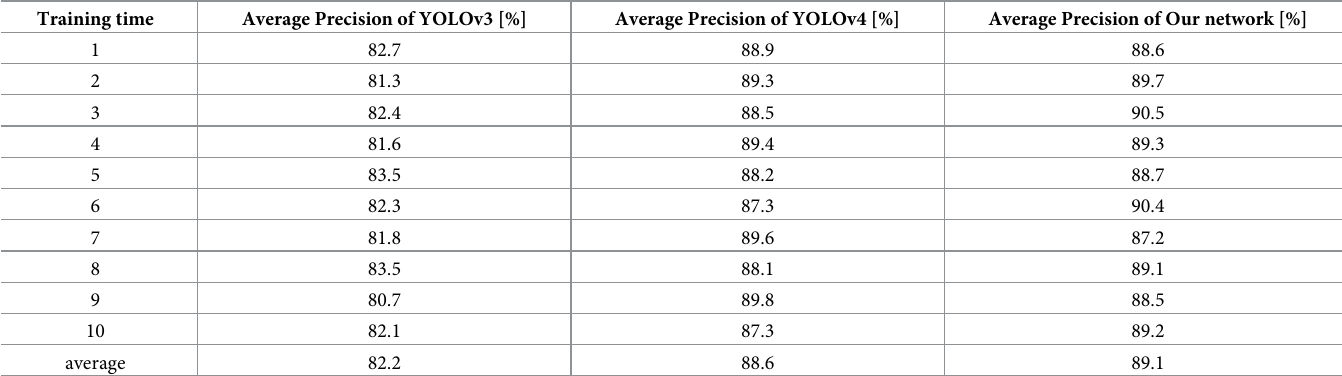
Table 4. The average precision of different networks in 10-fold cross validation.